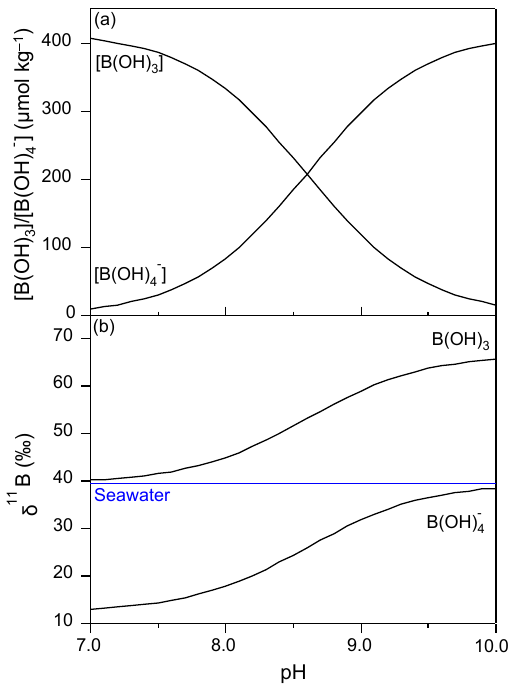
Figure 1. (a) Speciation of dissolved inorganic boron, B(OH) 3 and B(OH) − , as a function of seawater pH. (b) δ 11 B of dissolved inor- 4 ganic boron species as a function of seawater pH. The pK B is 8.6 at 25 ◦ C and 35psu (practical salinity units; Dickon, 1990), α is 1.0272 (Klochko et al., 2006), and δ 11 B SW is 39.61 (Foster et al.,